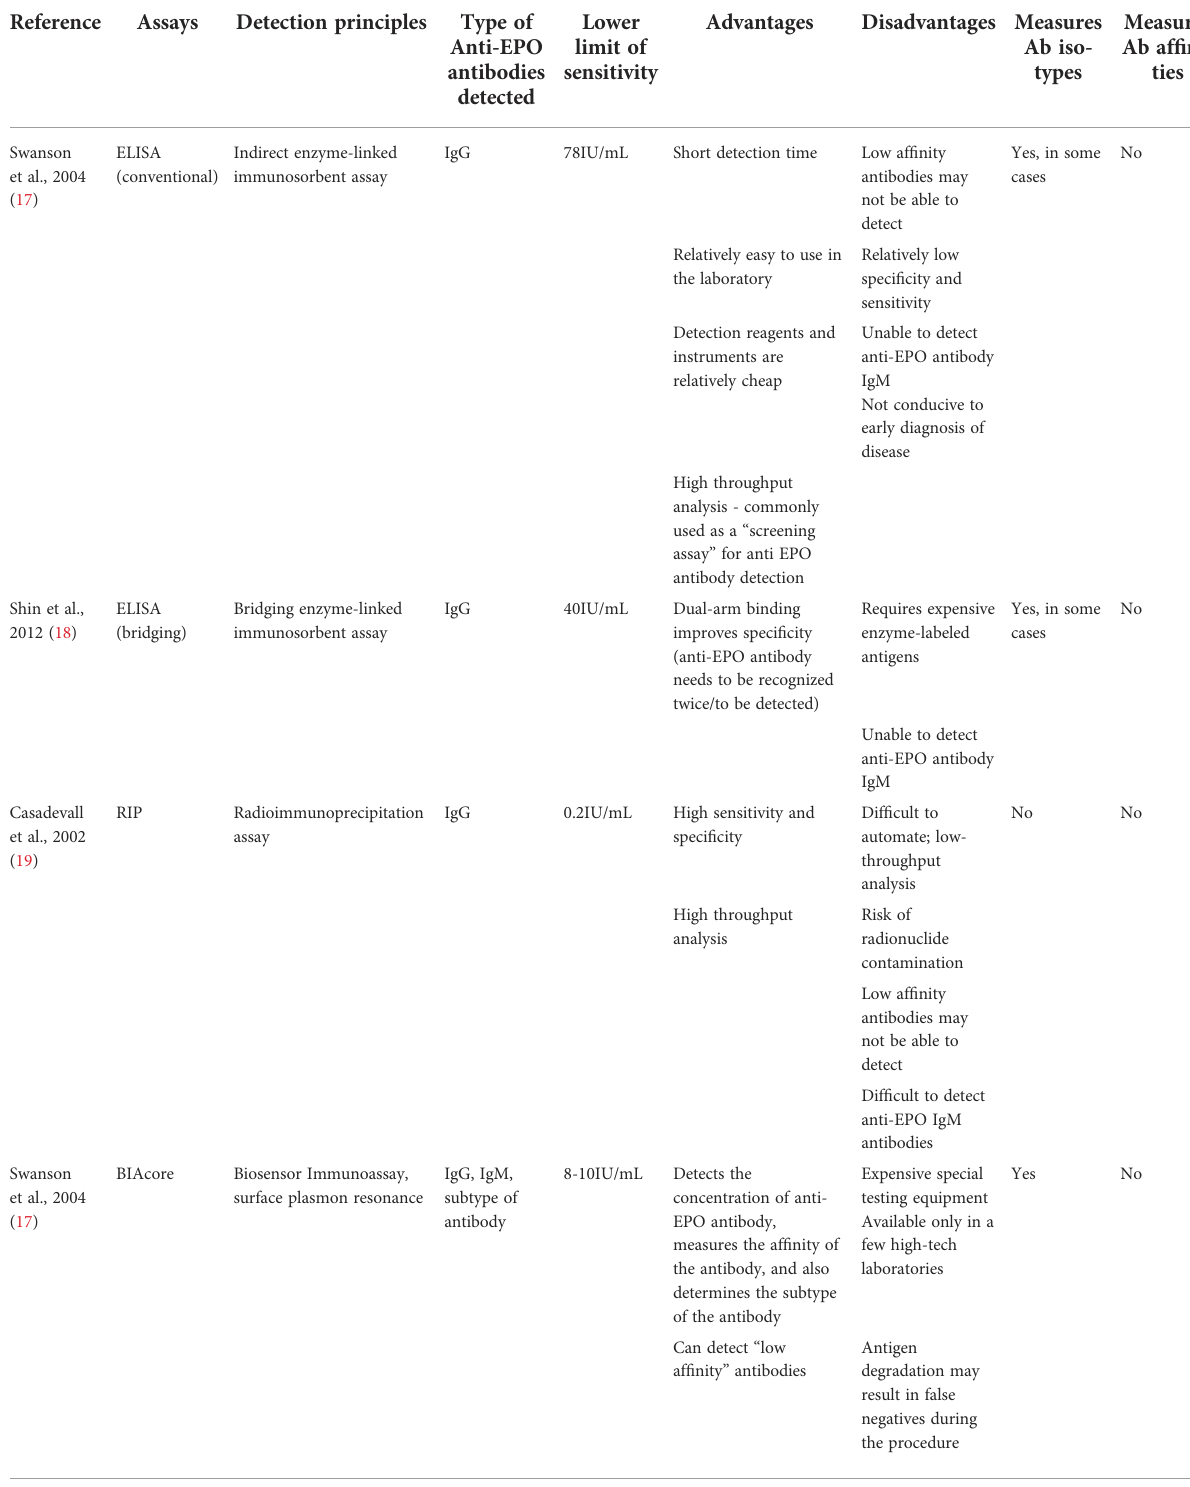
TABLE 2 Characteristics of the four assays used to measure anti-EPO